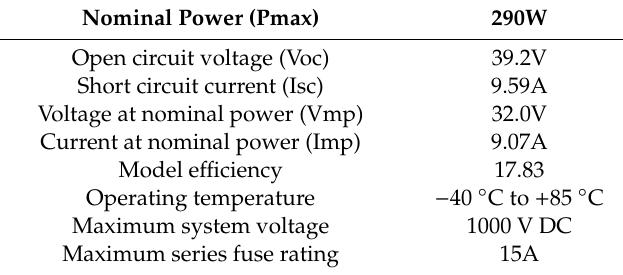
Table 4. Electrical characteristics of the selected PV